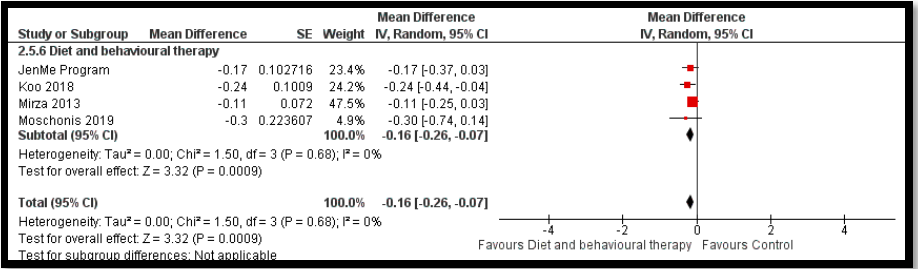
Figure 11. Forest plot for the effect of exercise and behavioural therapy interventions for obesity management on body mass index (BMI) z -score .